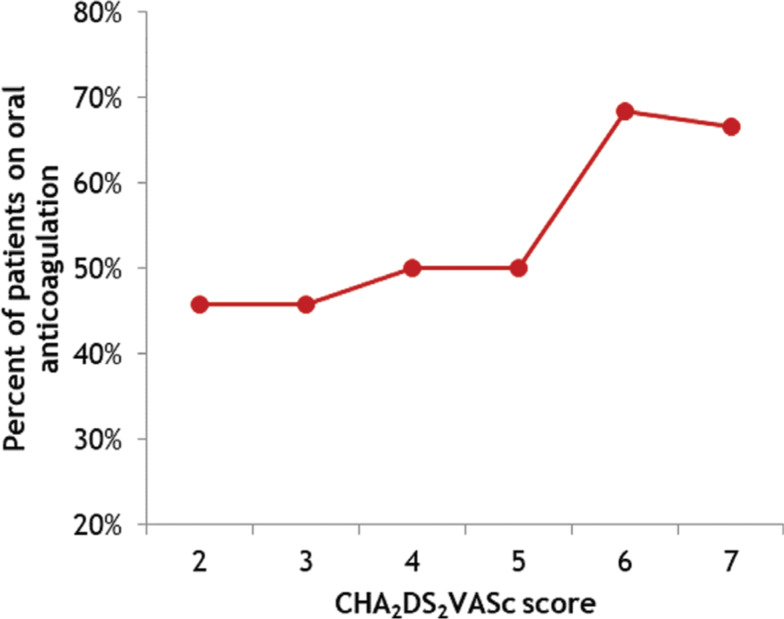
Percentage of patients with AF undergoing PCI who were prescribed oral anticoagulation on discharge for each CHA2DS2-VASc score.